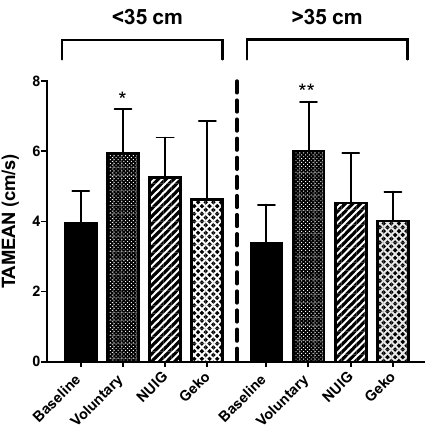
Figure 6. Effect of calf muscle circumference size on TAMEAN. For both calf muscle circumference of < 35 and > 35 cm, voluntarily contraction ( n = 10) only showed a significant increase on TAMEAN in comparison to baseline ( n = 10). NUIG ( n = 5) and the Geko device ( n = 3–4) showed no alteration. (* P < 0.05, ** P < 0.001 versus baseline). Data shown as ±